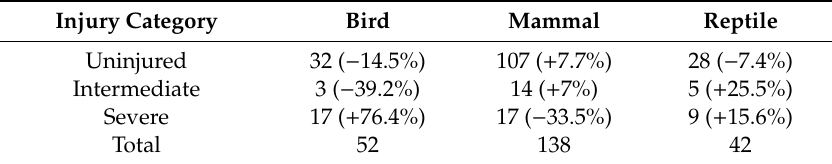
Table 7. Number of individuals from all three taxa of native by-catch (bird, mammal and reptile) in each of the summarised injury categories (uninjured, intermediate and severe). Percentage deviation is also displayed next to the corresponding value.